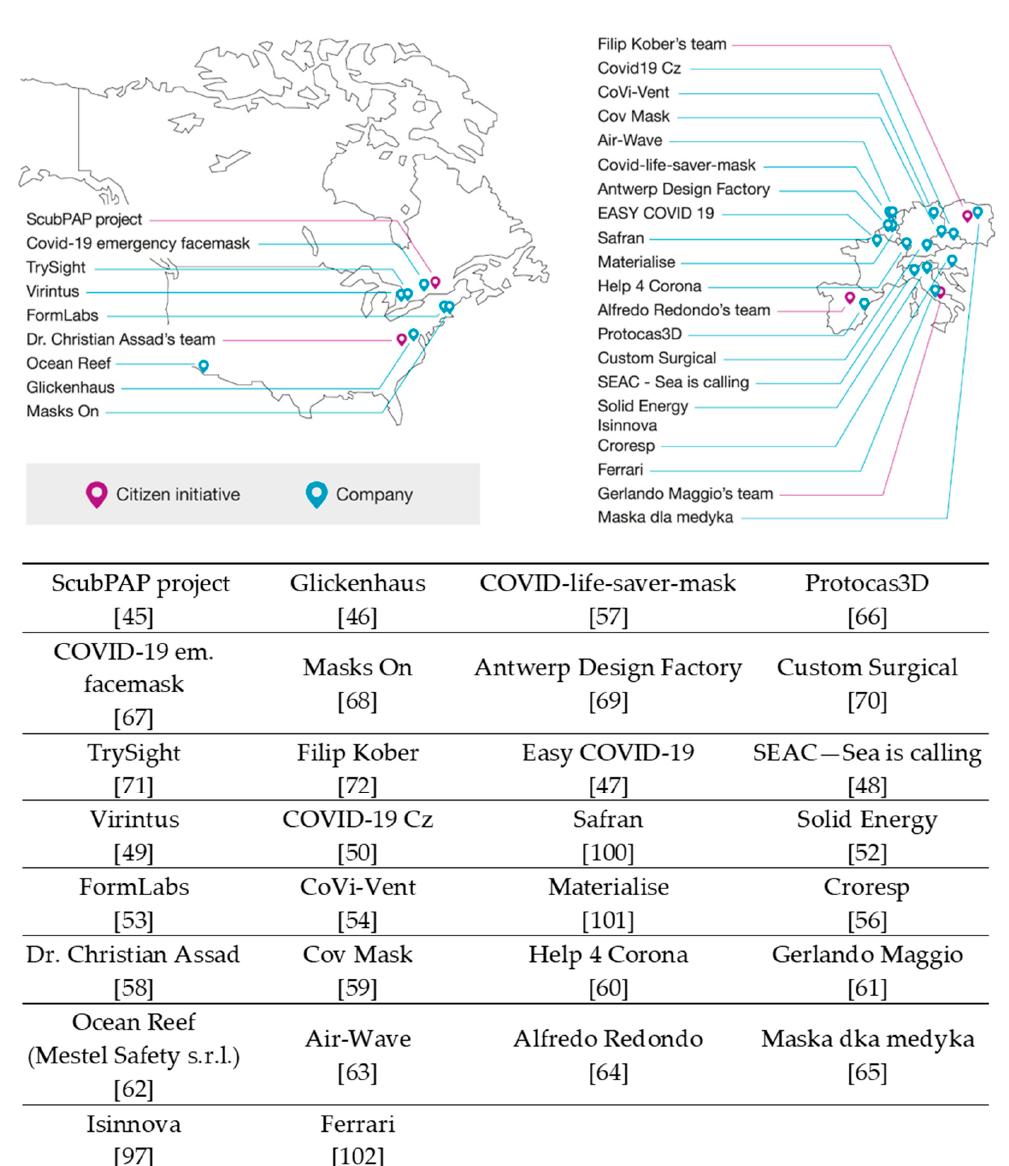
Figure 5. World map representing different initiatives in North America and Europe for manufacturing ecosystems for modified mask (MM) fabrication for use in healthcare institutes during the supply shortage in the first wave of the COVID-19 pandemic [45–50,52–54,56–72,97,100–102].